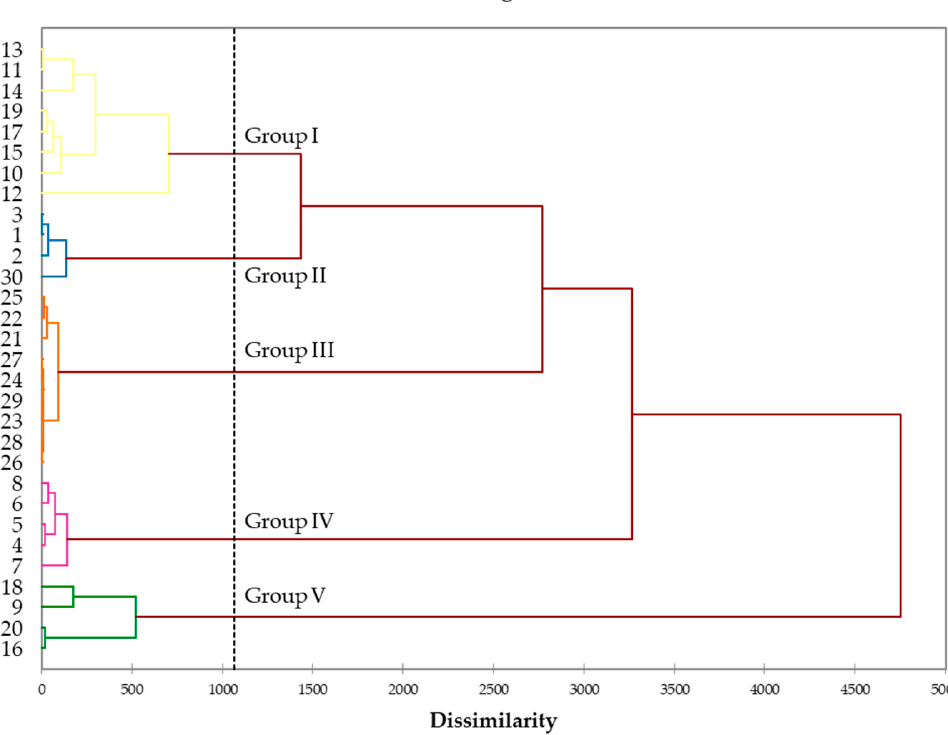
Figure 2. Dendrogram of hierarchical cluster analysis (HCA) of the 30 leaf EO samples from N. acuminata.